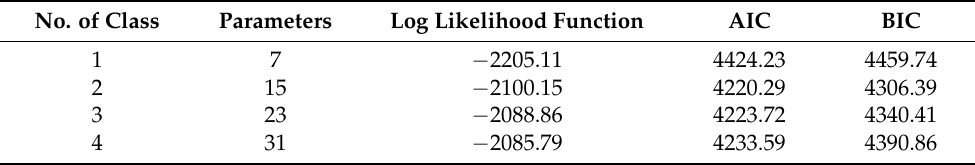
Table 9. Statistics for latent-class regression models ( annoyance sense